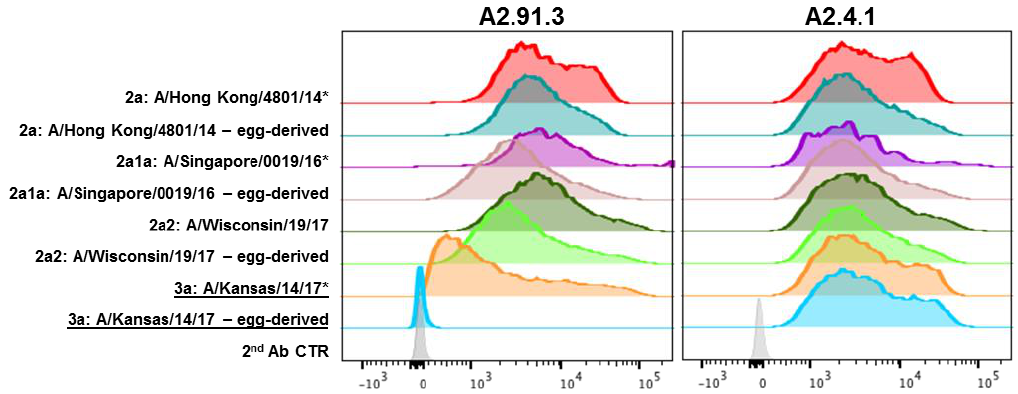
Figure 4. FACS analysis of recent wild-type and egg-passaged H3N2 strains. HA genes from 2014 to